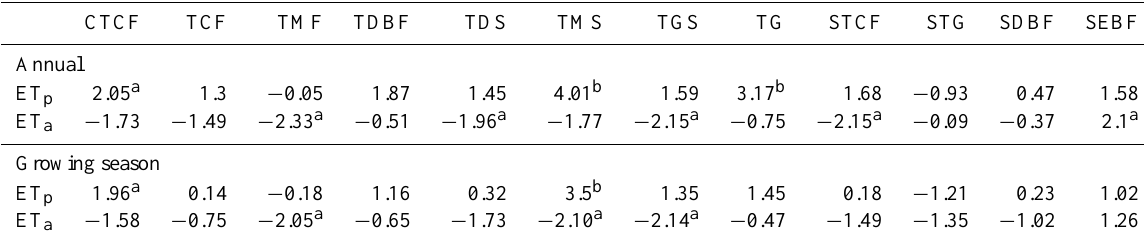
Table 5. Seasonal Mann–Kendall (SMK) trend tests of ET p and ET a by vegetation type from 1982 to 2006.